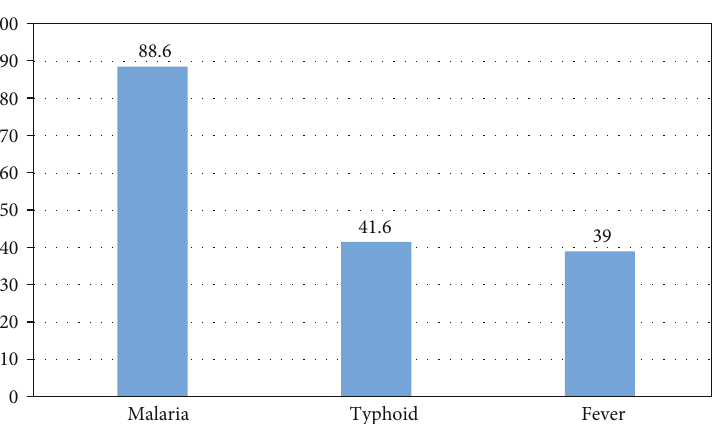
Figure 1: Three major health conditions in the community identi fi ed by community members in Ebonyi,